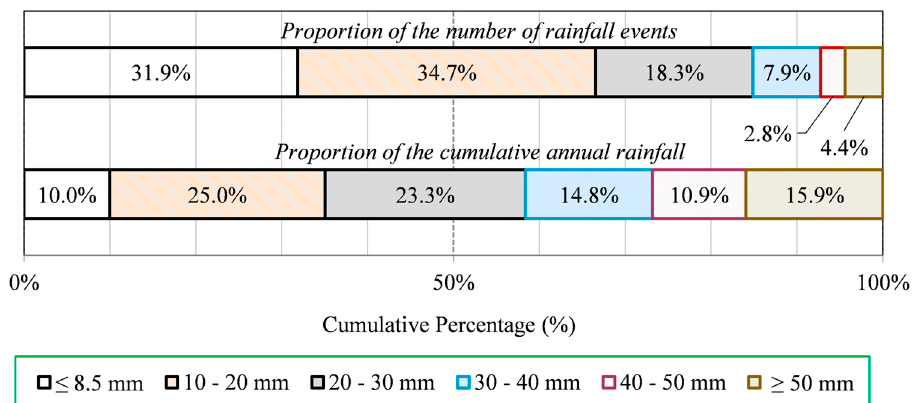
Figure 2. Distribution of rainfall events monitored in the Tougou watershed over the period 2010–2018. The distribution in terms of number of events is presented in the upper bar and the distribution in terms of rainfall volume is presented in the lower bar.